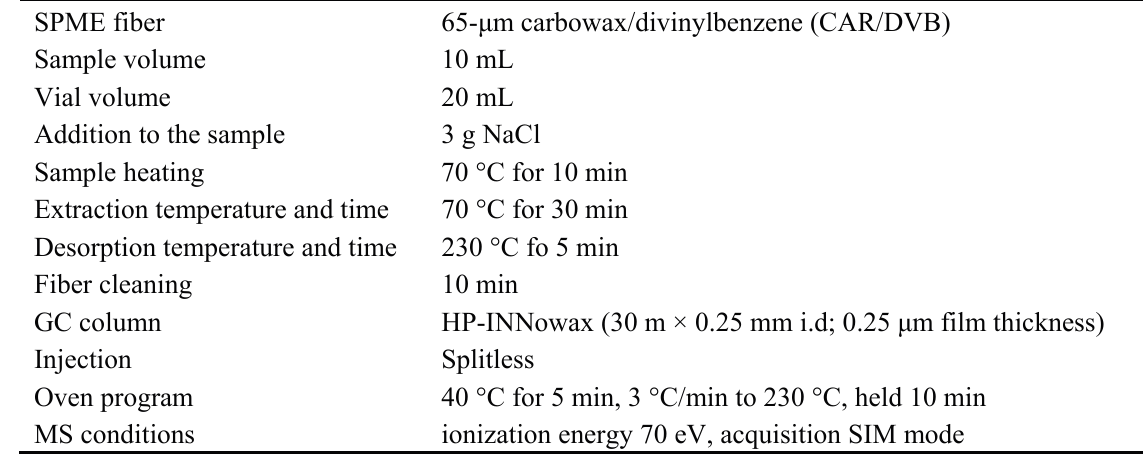
Table 3. SPME-GC/MS conditions used to study the evolution of volatile compounds of Raboso Piave wine during aging in five different types of wood barrels